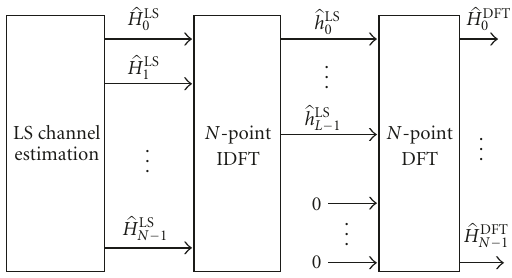
Figure 1: Block diagram of the conventional DFT-based channel